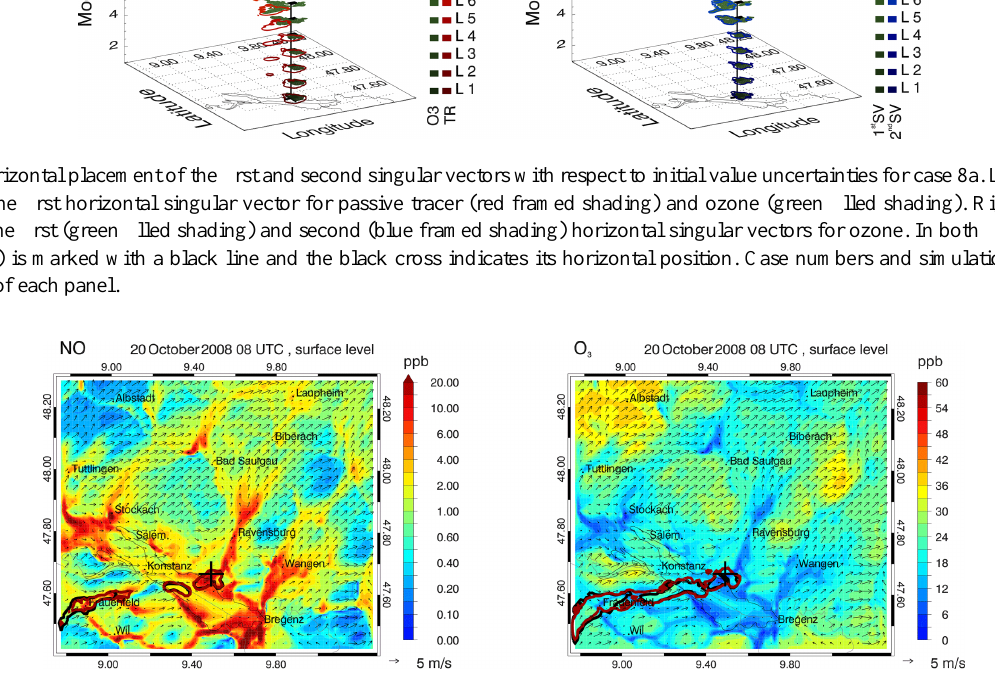
Figure 5. Initial concentrations and horizontal placement of the first and second singular vectors with respect to initial value uncertainties for case 6. Illustrated are results for NO (left panel) and O 3 (right panel) at surface level. The 0.01 isopleths of the first and second horizontal singular vectors are indicated with red and black lines, respectively, and the horizontal position of the final profile VP( t F ) is marked with a black cross. Date and time are denoted above each